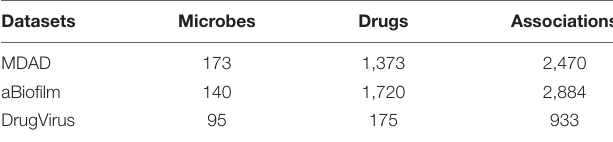
TABLE 2 | The statistics for each microbe-drug association dataset.